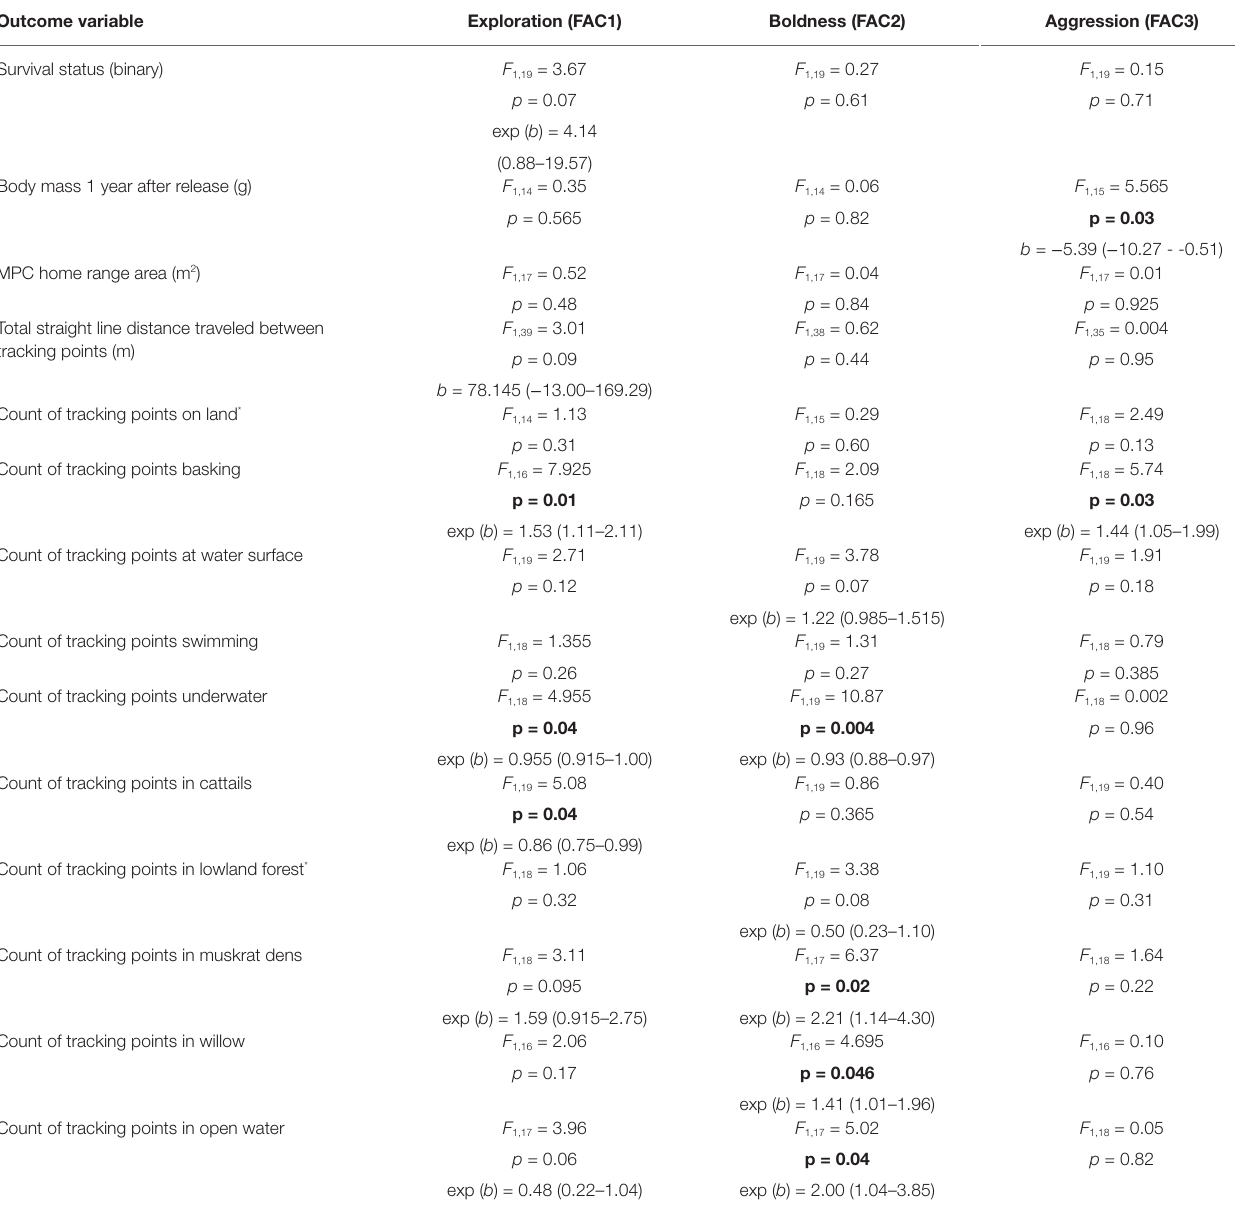
TABLE 3 | Relationships between personality scores and variables related to post-release condition, behavior, and microhabitat